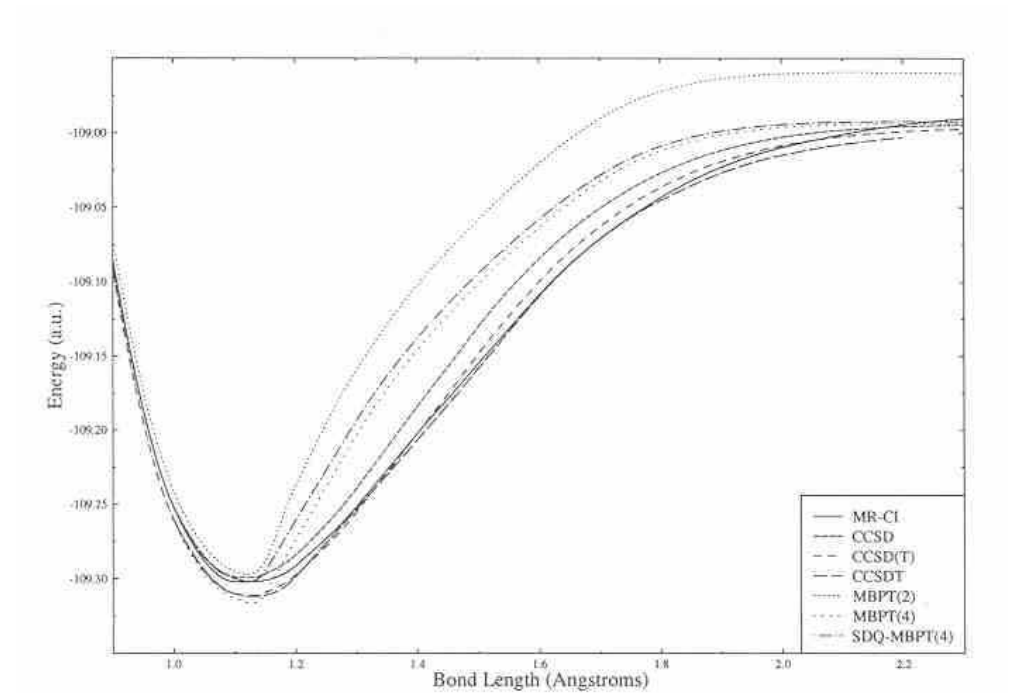
Figure 2: Various potential energy curves for N 2 with a UHF